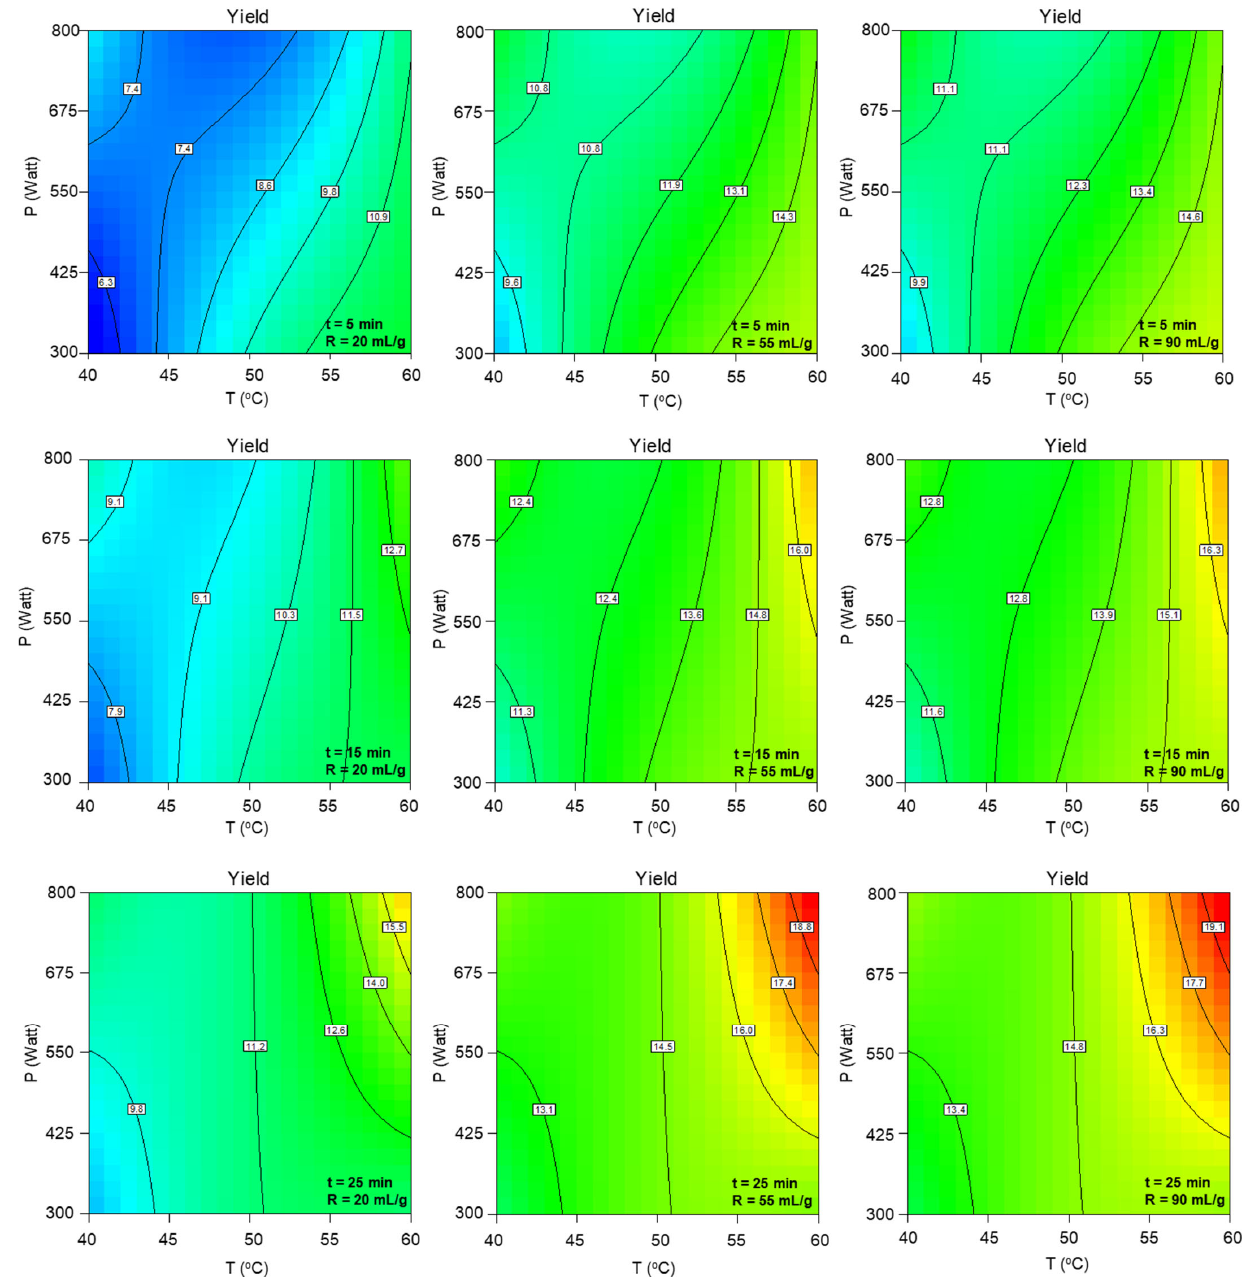
Figure A1. Contour plots of MAE yield as a function of extraction temperature and microwave power at the low, central and high levels of extraction duration and solvent ‐ to ‐ biomass ratios.